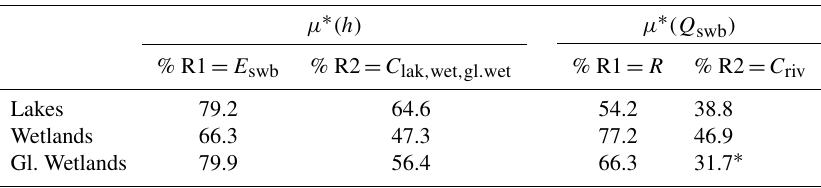
Table 4. Percentage fractions of the most frequent parameter for rank 1 (R1) and 2 (R2) of all cells with more than 25% coverage of a lakes, global wetland, or